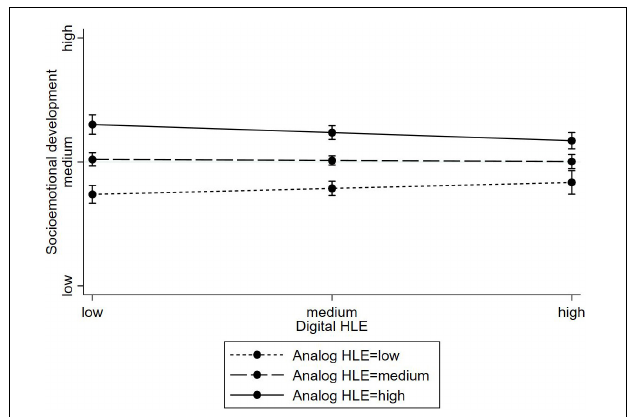
FIGURE 1 | Moderating effects of analog HLE on the association between digital HLE and socioemotional development (toddler age